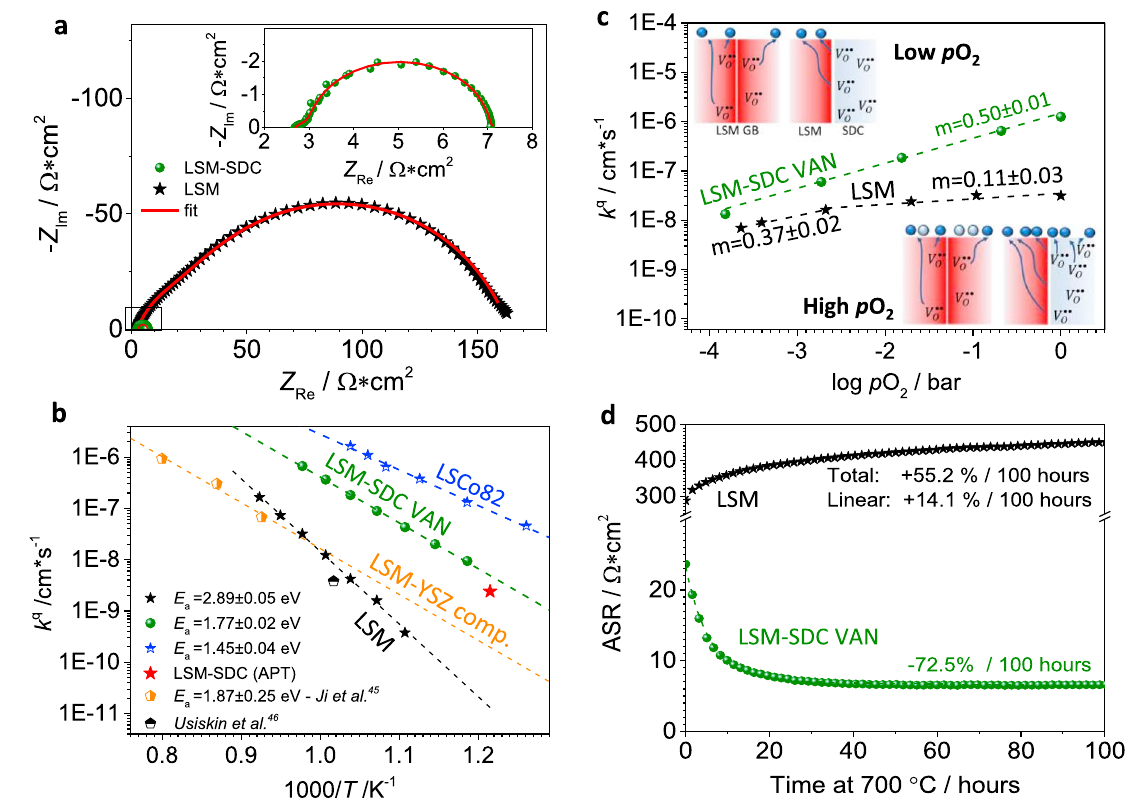
Fig. 3 Electrochemical performance of LSM (black stars) and LSM-SDC (green bullets) nanocomposites. a Representative initial EIS Nyquist plots measured at 750 °C (air atmosphere) in an out-of-plane con fi guration and using a porous Ag layer as a low impedance counter-electrode for LSM and LSM-SDC. The inset shows the LSM-SDC impedance arc on a smaller scale. b Surface exchange coef fi cient k q as a function of inverse temperature, as compared to stoichiometric LSM (from our labs and from Ref. 46 ), state-of-the-art LSM-YSZ dense composites (from Ref. 45 ) and to state-of-the-art La 0.8 Sr 0.2 CoO 3 (our lab). The red star represents the value resulting from the FEM simulation of the APT 18 O fraction pro fi le. c p O 2 dependence for k q . The slopes for LSM and LSM-SDC are indicated. d ASR vs time for LSM and LSM-SDC, measured during ageing treatment. The lines are intended as a guide to the